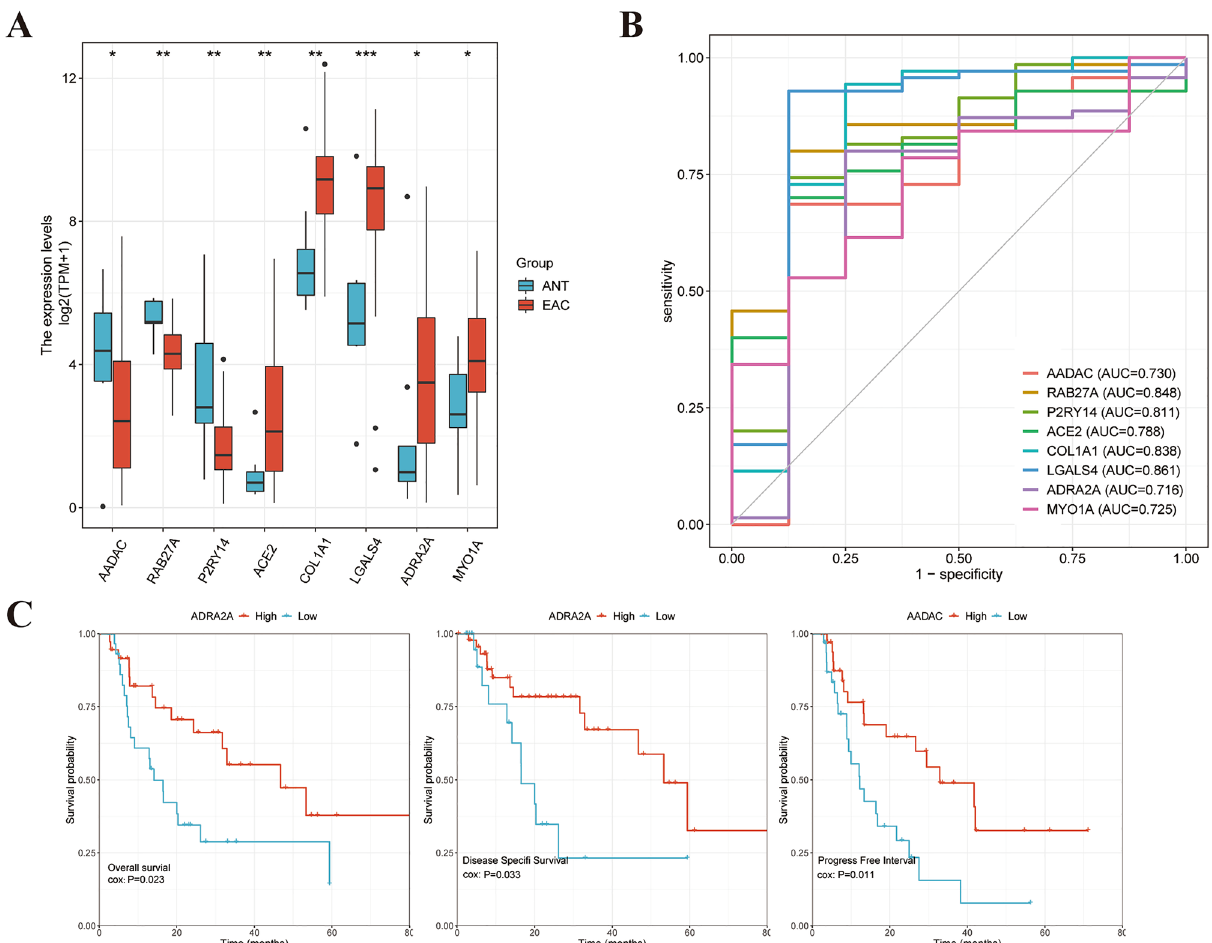
Figure 4. Further validation in TCGA database (*p < 0.05, **p < 0.01, ***p < 0.001). ( A ) Box plot assessing the expression of 8 genes in TCGA database; ( B ) ROC curve for the 8 genes; ( C ) Survival plots of ADRA2A